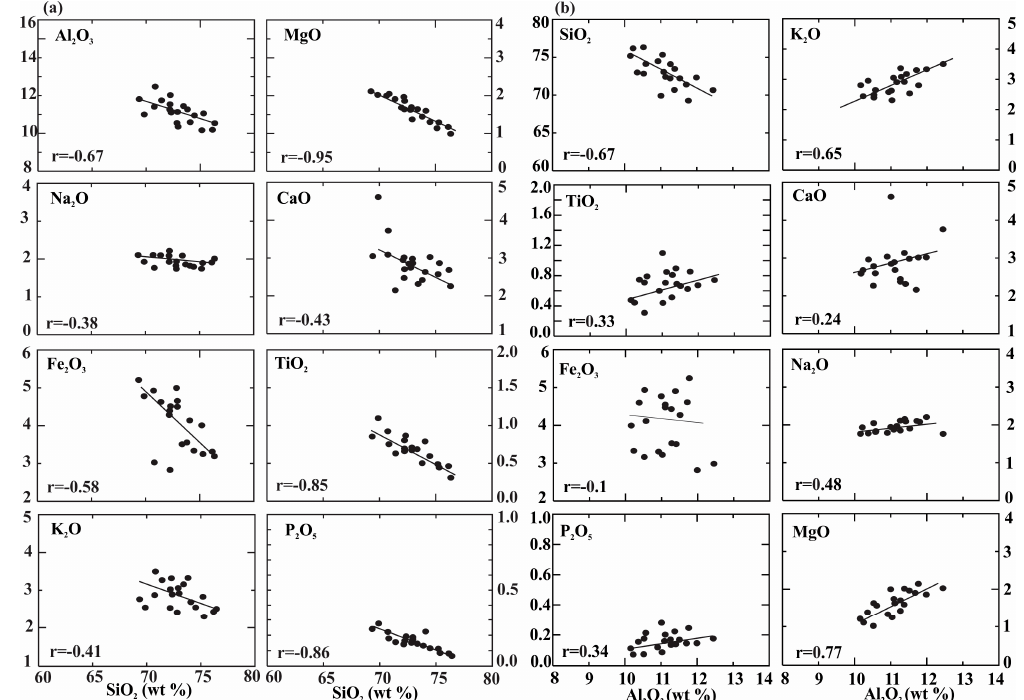
Figure 3. Selected major oxide variation diagrams for the Brahmaputra River sediments. ( a ) Plots of SiO 2 (wt.%) vs. different oxides; ( b ) plots of Al 2 O 3 (wt.%) vs. different oxides. Solid lines (fitted by eye) are indicative of trends in the studied samples. Black dots in the figure represent Brahmaputra River sediment samples. For the Y axis, major oxides are given in wt. %.